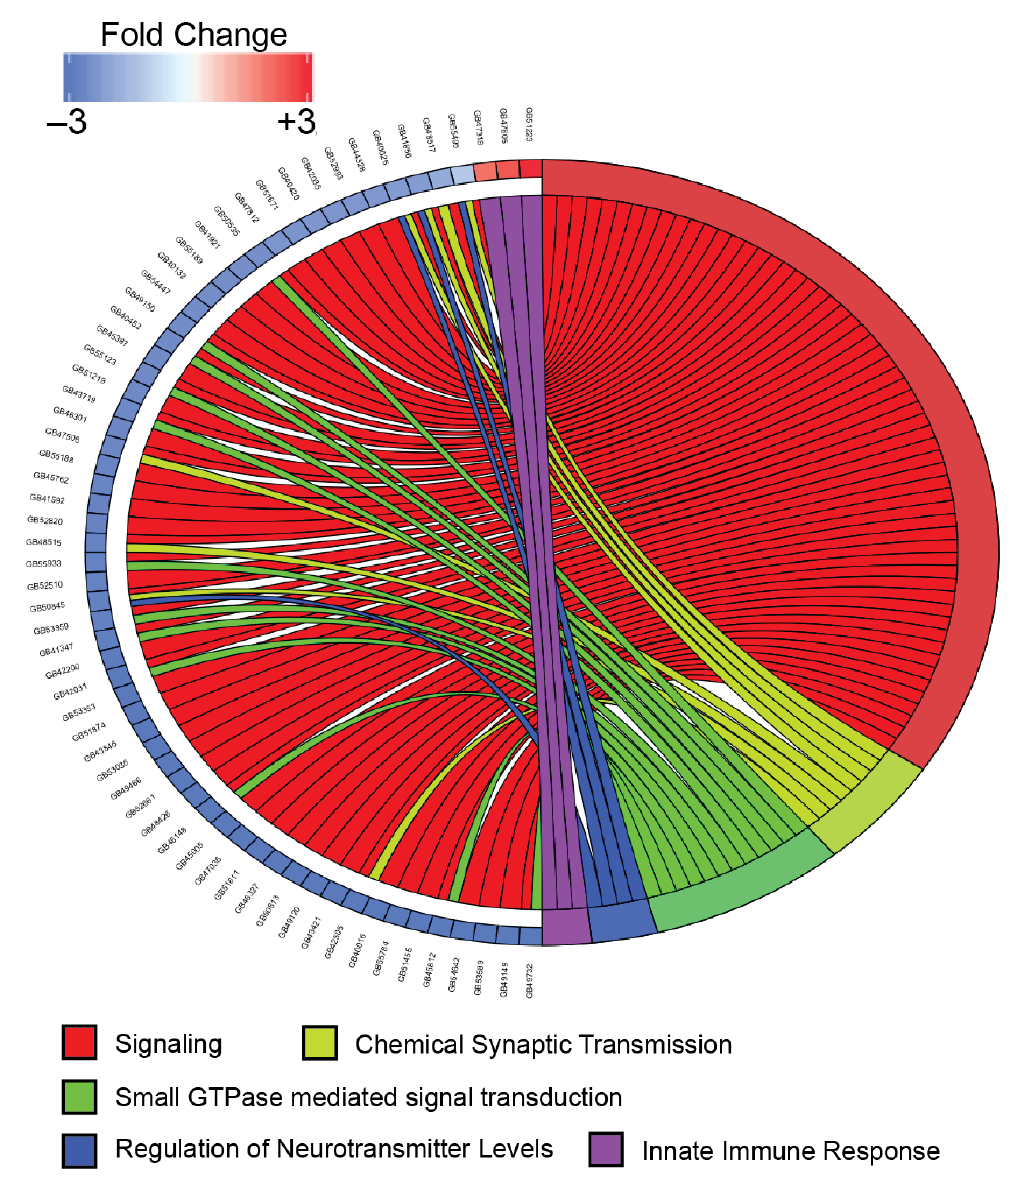
Figure 4. Chord plot comparing the expression levels of selected genes and their relationship to specific biological process gene ontology terms. Gene expression changes are shown for selected genes that were differentially expressed (FDR < 0.001 by DESeq2 and edgeR) and represented in the indicated gene ontology category. Expression level changes (log2 fold change) are shown for the comparison of DWV-infected samples to mock-infected samples. Connections from the right side of the figure to the left signify associations between genes and selected biological process categories. Genes are shown in the following biological process categories: GO:0023052 (signaling (red)), GO:0007268 (chemical synaptic transmission (light green)), GO:0007264 (small GTPase mediated signal transduction(green)), GO:0001505 (regulation of neurotransmitter levels (blue)), and GO:0045087 (innate immune